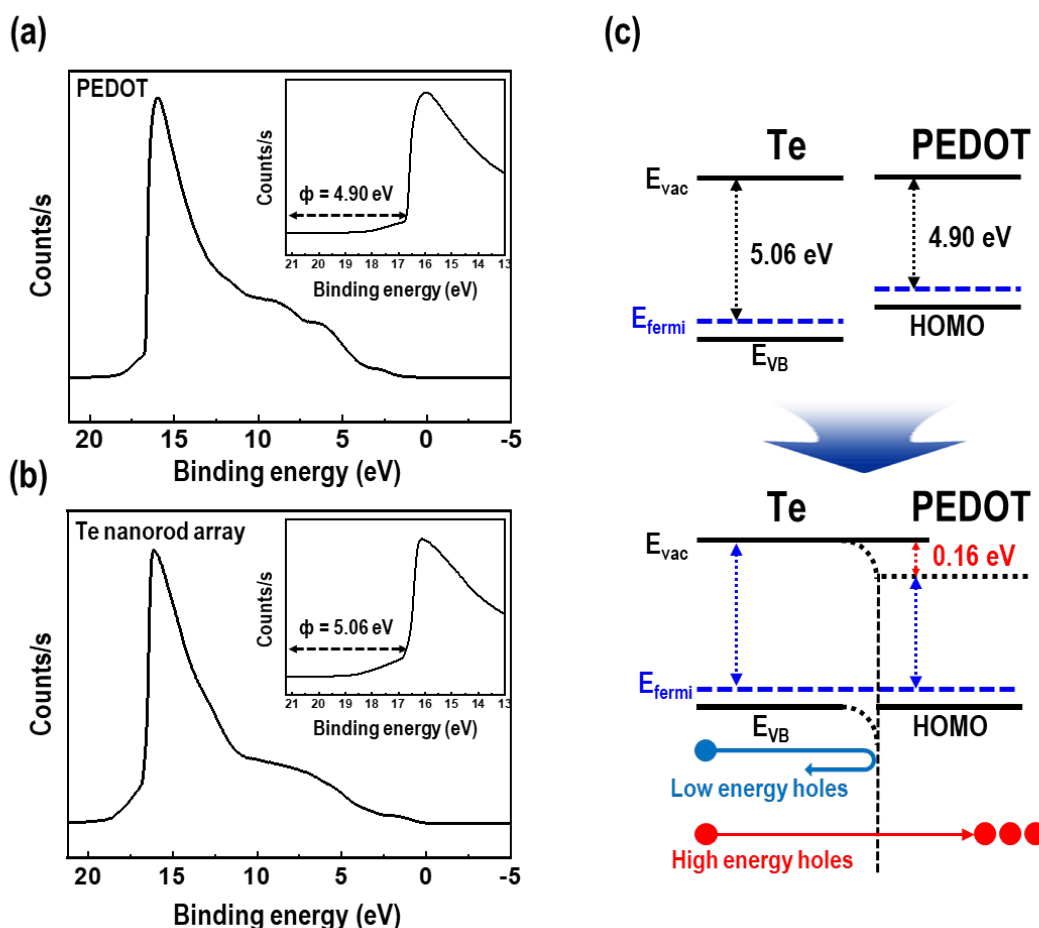
Figure 9. Ultraviolet photoelectron spectroscopy (UPS) spectra of ( a ) PEDOT film and ( b ) Te nanorod array (the insets show the calculated work function). ( c ) Schematic diagram of band-structure at the interfaces between the Te nanorod array and PEDOT.